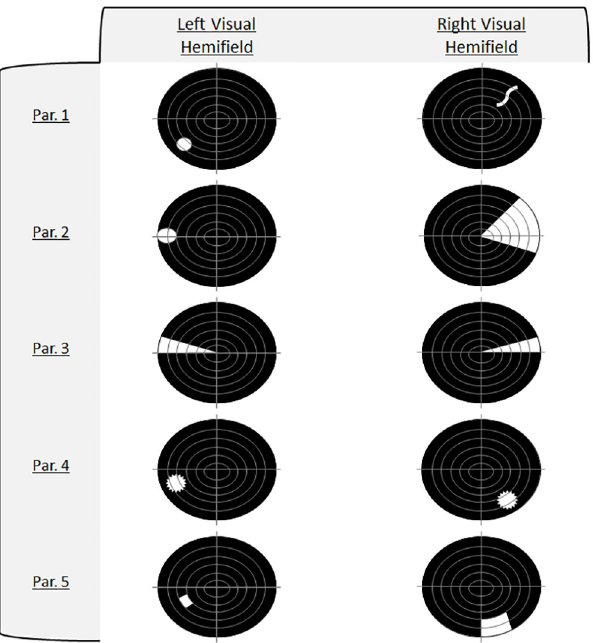
Fig 6. Phosphene features. Visual field plots highlighting phosphene characteristics depicted by each participant.